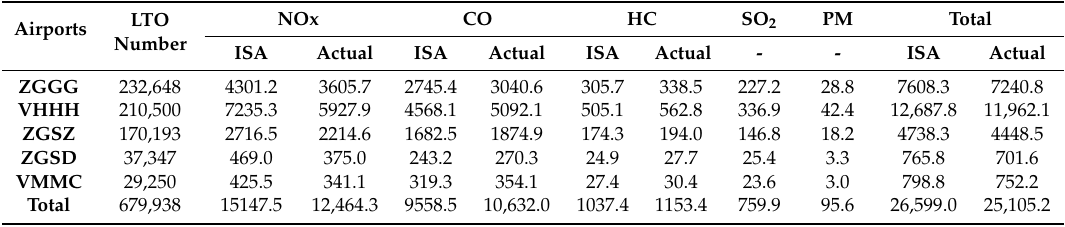
Table 3. Aircraft landing and take-o ff (LTO) emissions of the five major airports in the GBA in 2017 (in